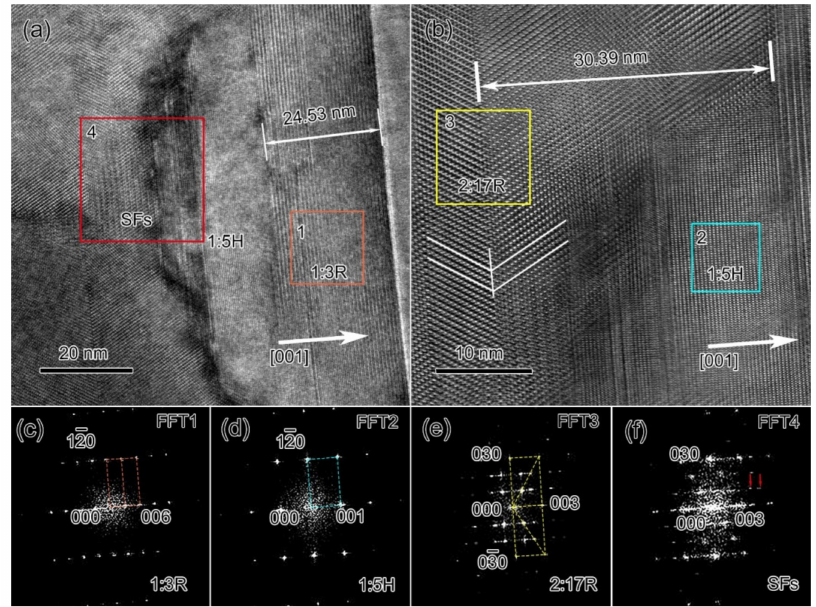
Figure 7. HR-TEM images ( a , b ) and FFT patterns of 1:3R precipitates ( c ), 1:5H precipitates ( d ), 2:17R twin ( e ), and SFs ( f ) at the grain boundaries for the final Sm 25 Co 46.9 Fe 19.5 Cu 5.6 Zr 3.0